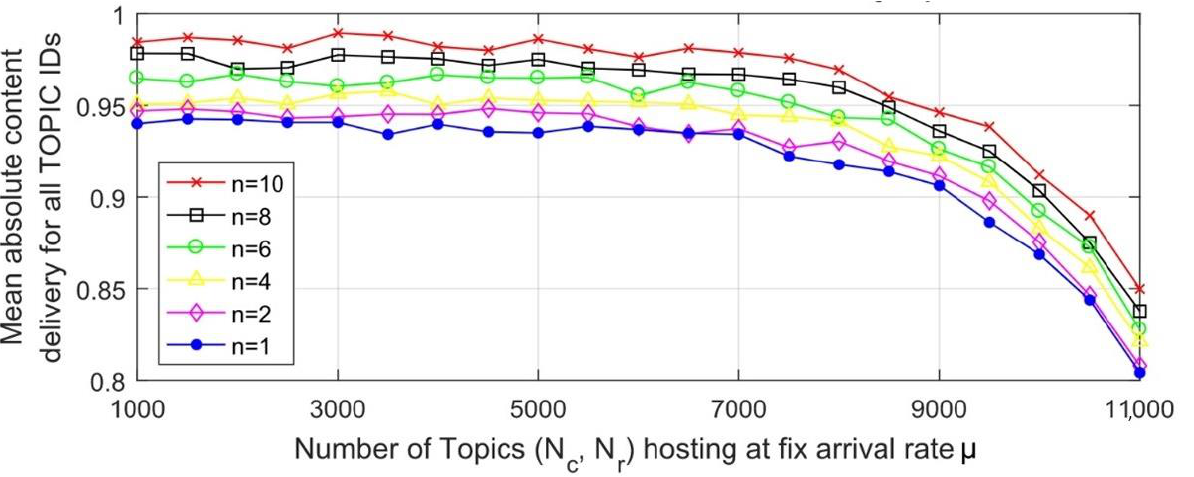
Figure 10. Mean absolute content delivery for collective topic IDs w.r.t connected hosts at fixed arrival rate for n = 1, 2, 4, 6, 8, 10.